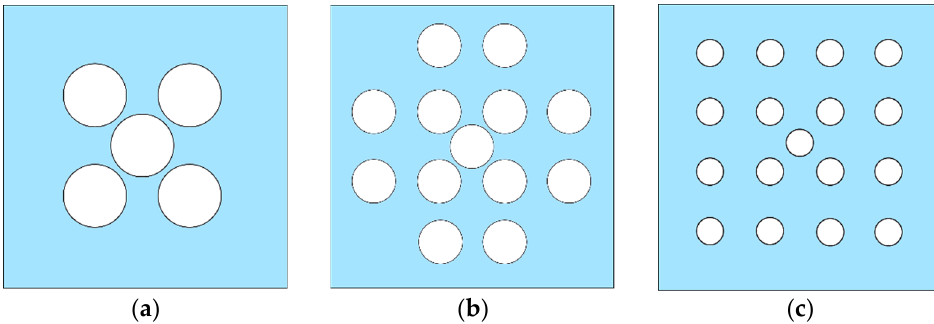
Figure 3. Examples of the arrays which meet Condition 1. ( a ) 5-element. ( b ) 13-element. ( c ) 17-element. Condition 2: The centers of all sub-apertures (except sub-aperture 0) are located on